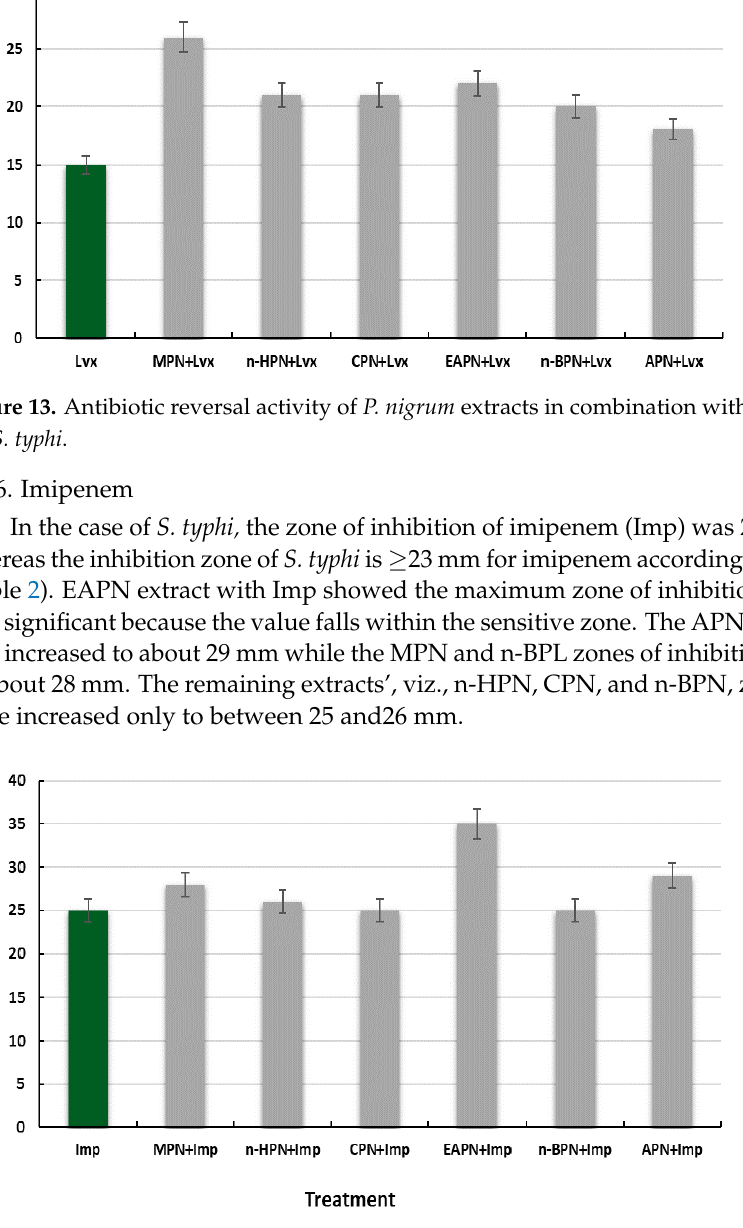
Figure 12. Antibiotic reversal activity of P. nigrum extracts in combination with tigecycline (10 μg) for S. typhi.